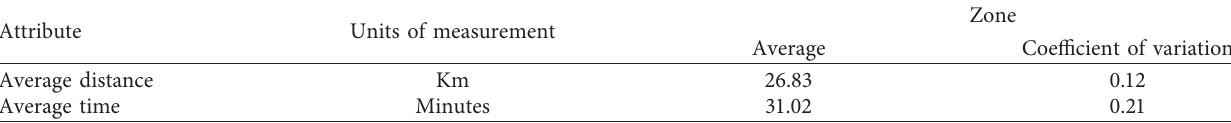
Table 3: Average values of the cost attributes.